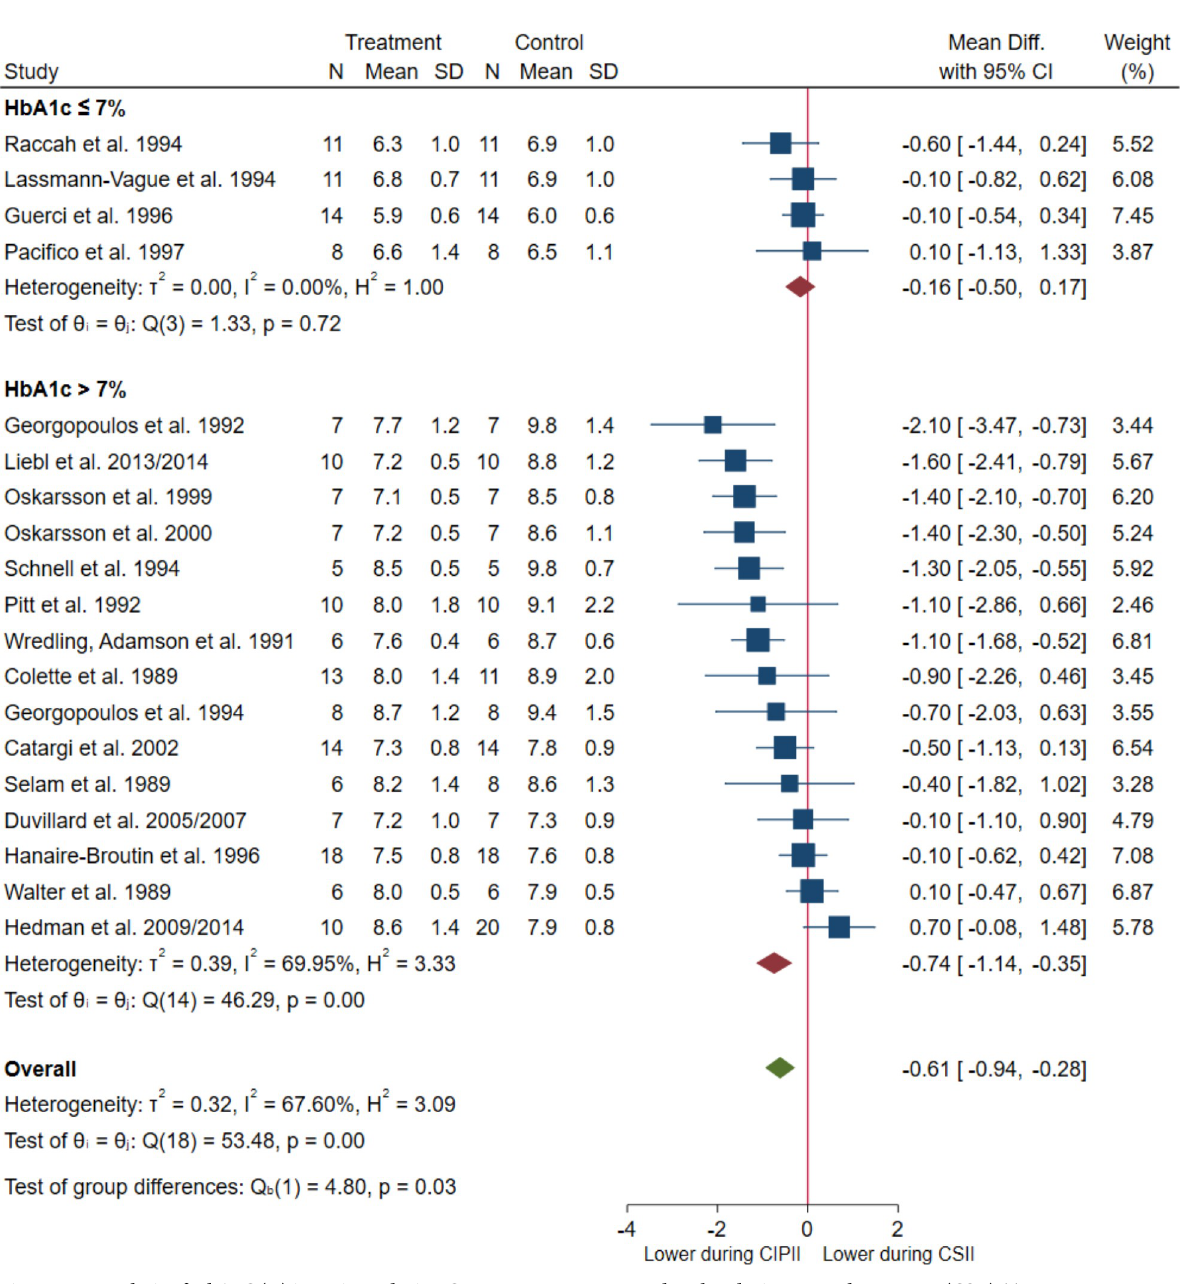
Fig 2. Meta-analysis of HbA1C (%) in patients during CIPII treatment compared to that during control treatment (CSII). Treatment, continuous intraperitoneal insulin infusion (CIPII); Control, continuous subcutaneous insulin infusion (CSII). Studies ordered by effect size (mean difference) and divided into subgroups: HBA1c levels � 53.0 mmol/mol ( � 7%) and HbA1c levels > 53.0 mmol/mol ( > 7%) during control treatment (CSII).